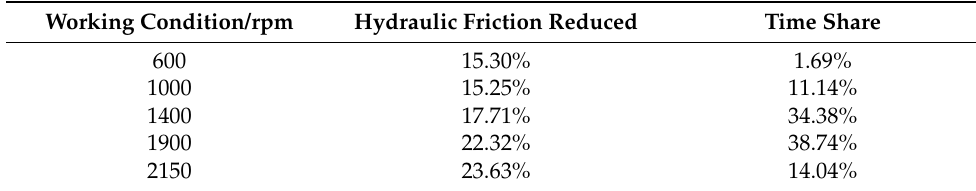
Table 10. The endurance cycle and friction